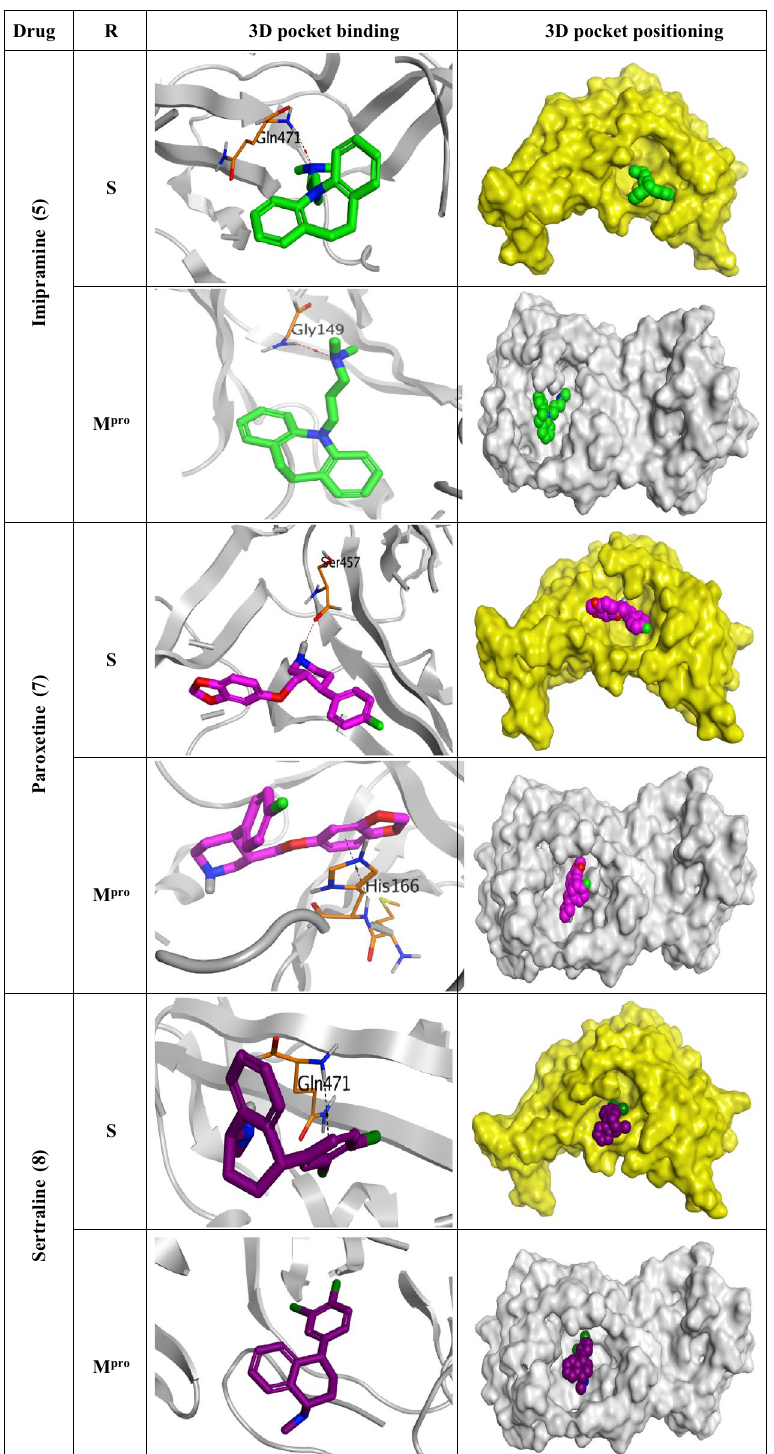
Table 3. 3D pictures of the receptor interactions and positioning for the most promising antidepressant drugs (Imipramine 5, Paroxetine 7, and Sertraline 8) inside the S and M pro pockets of MERS-CoV. Red dash represents H-bonds and black dash represents H-pi interactions.